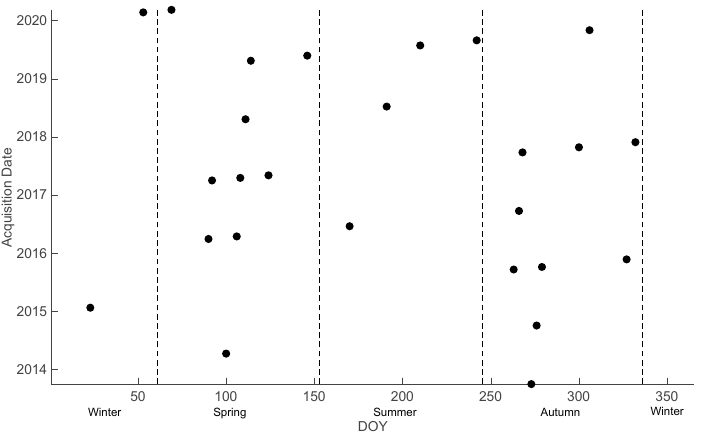
Figure 2. A scatter plot illustrating the acquisition Day of Year (DOY) of 26 MODIS-Landsat image pairs. The gray dash lines show season divisions.